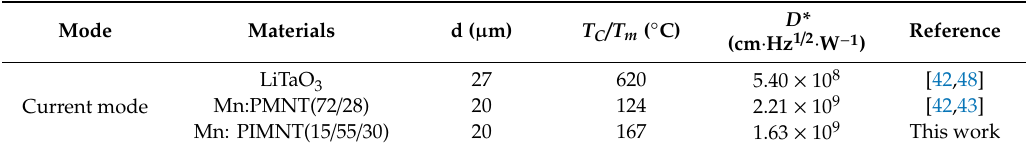
Figure S1: (a) Imaginary parts (Z”) versus real parts (Z (cid:48) ) measured from 100 Hz to 2 MHz, (b) imaginary parts (Z”) versus frequency measured from 100 Hz to 2 MHz and (c) linear fitting of relaxation frequency ( f max ) of the Mn:PIMNT single crystals annealed at 400 ◦ C, Figure S2: (a) Imaginary parts (Z”) versus real parts (Z (cid:48) ) measured from 100 Hz to 2 MHz, (b) imaginary parts (Z”) versus frequency measured from 100 Hz to 2 MHz and (c) linear fitting of relaxation frequency ( f max ) of the Mn:PIMNT single crystals annealed at 500 ◦ C, Figure S3: (a) Imaginary parts (Z”) versus real parts (Z (cid:48) ) measured from 100 Hz to 2 MHz, (b) imaginary parts (Z”) versus frequency measured from 100 Hz to 2 MHz and (c) linear fitting of relaxation frequency ( f max ) of the Mn:PIMNT single crystals annealed at 600 ◦ C , Figure S4: (a) Imaginary parts (Z”) versus real parts (Z (cid:48) ) measured from 100 Hz to 2 MHz, (b) imaginary parts (Z”) versus frequency measured from 100 Hz to 2 MHz and (c) linear fitting of relaxation frequency ( f max ) of the Mn:PIMNT single crystals annealed at 700 ◦ C, Figure S5: (a) Imaginary parts (Z”) versus real parts (Z (cid:48) ) measured from 100 Hz to 2 MHz, (b) imaginary parts (Z”) versus frequency measured from 100 Hz to 2 MHz and (c) linear fitting of relaxation frequency ( f max ) of the Mn:PIMNT single crystals annealed at 800 ◦